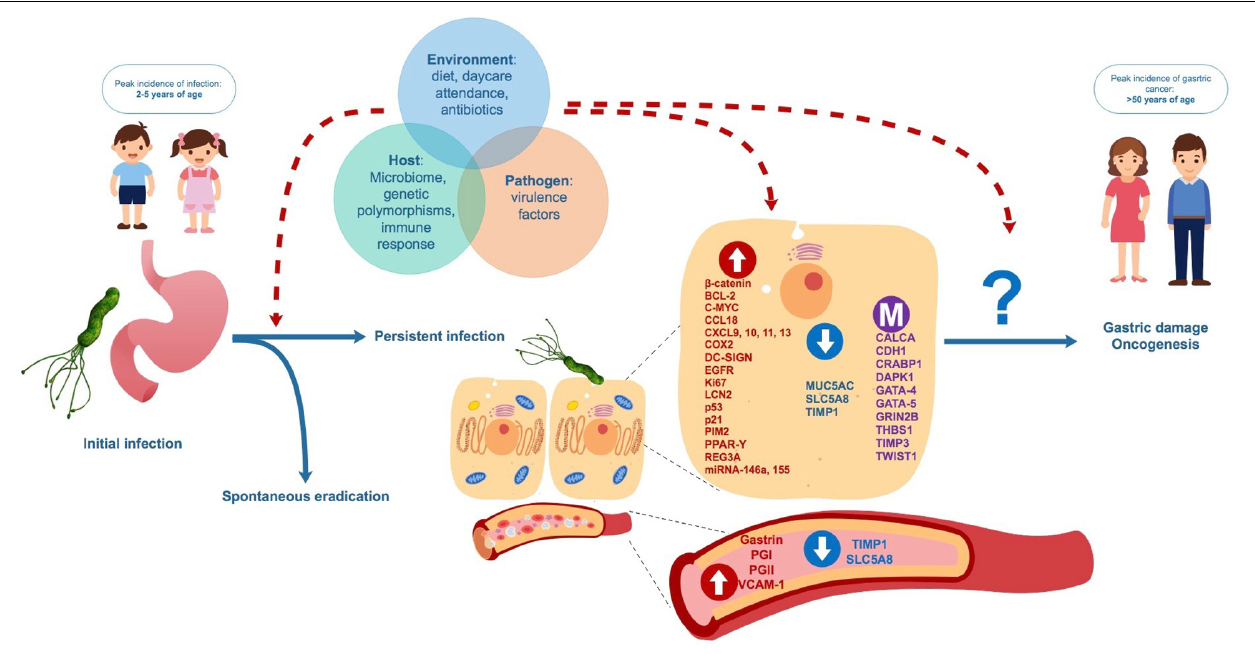
FIGURE 3 | Proposed natural evolution of H. pylori infection and biomolecular changes from asymptomatic childhood infection to adult gastric diseases. Interaction between factors related to the environment, the host and the pathogen may influence persistence H. pylori of infection, biomolecular changes in gastric cells and blood and the future development of benign and malign gastric